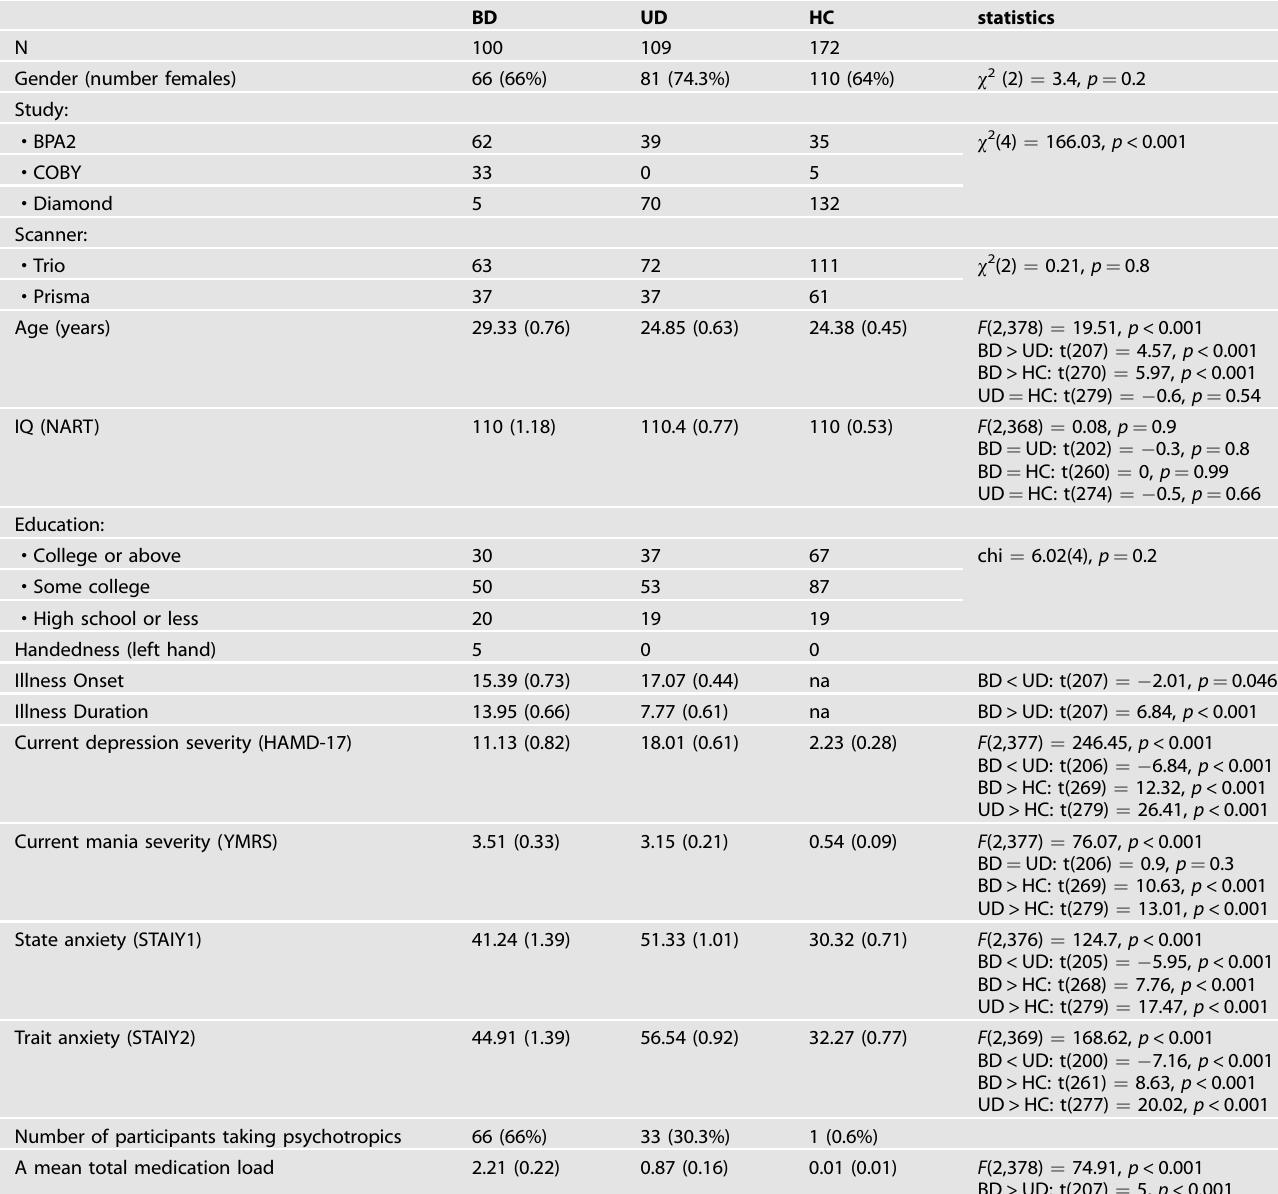
Table 2. Demographic and clinical